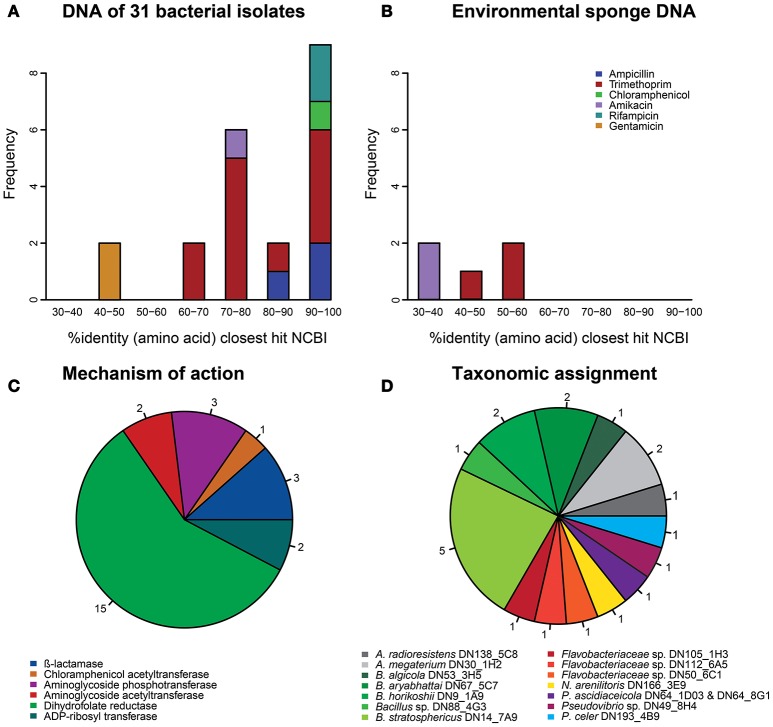
Characterization of the 26 antibiotic resistance genes that were identified with high confidence (E < 1.0E-7). (A) Amino acid identity distribution of the resistance genes that were obtained from the library of 31 sponge bacteria with their best hit (bitscore sorted) in NCBI's database. (B) Amino acid identity distribution of the resistance genes that were obtained from libraries based on DNA from sponge tissue with their best hit (bitscore sorted) in NCBI's database. (C) The mechanisms of action of all 26 resistance genes. (D) The taxonomic assignments of the resistance genes that were obtained from the library of 31 sponge bacteria.